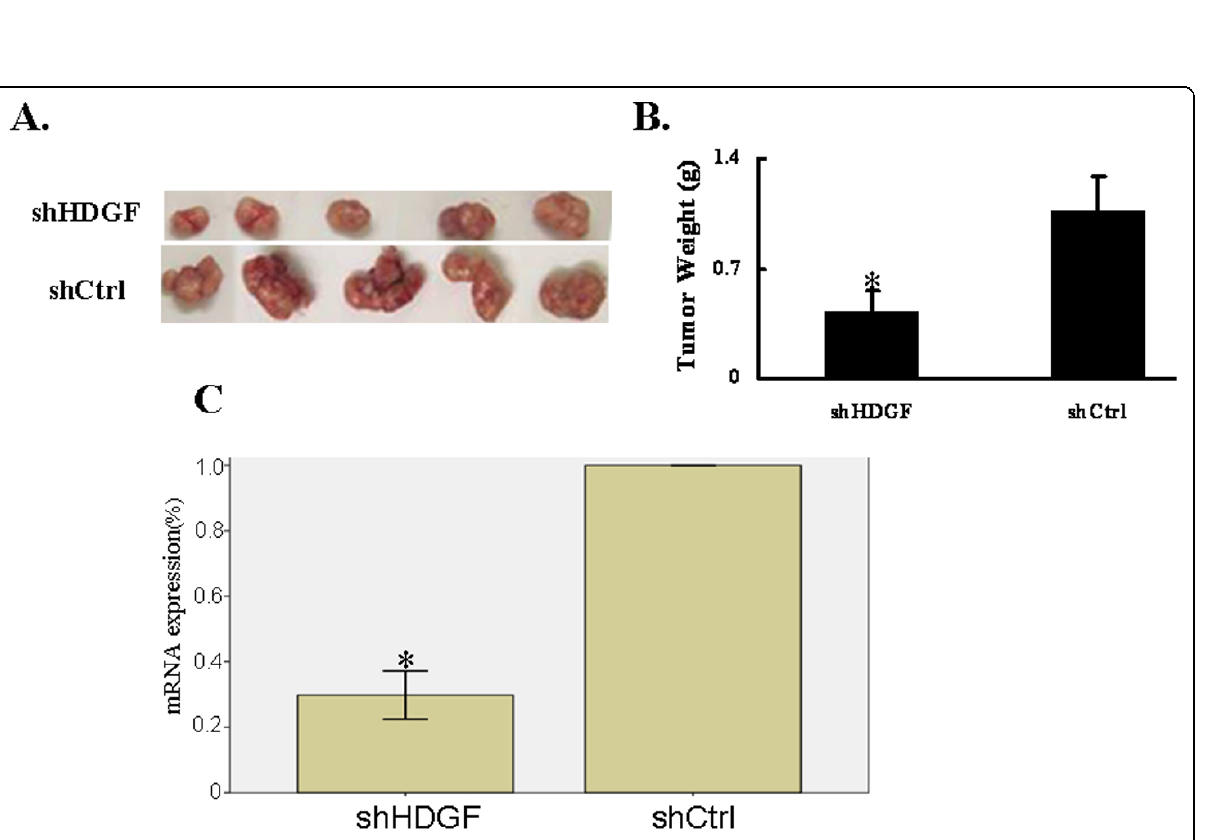
Figure 6 Down-regulation of HDGF inhibited in vivo xenograft tumor growth . A. shCtrl and shHDGF cells were injected subcutaneously into nude mice (N = 5 for each group) and the tumors were isolated two weeks later. B. Tumor weights were quantified from 5 mice and presented as mean ± SD. * P < 0.05, as compared to shCtrl